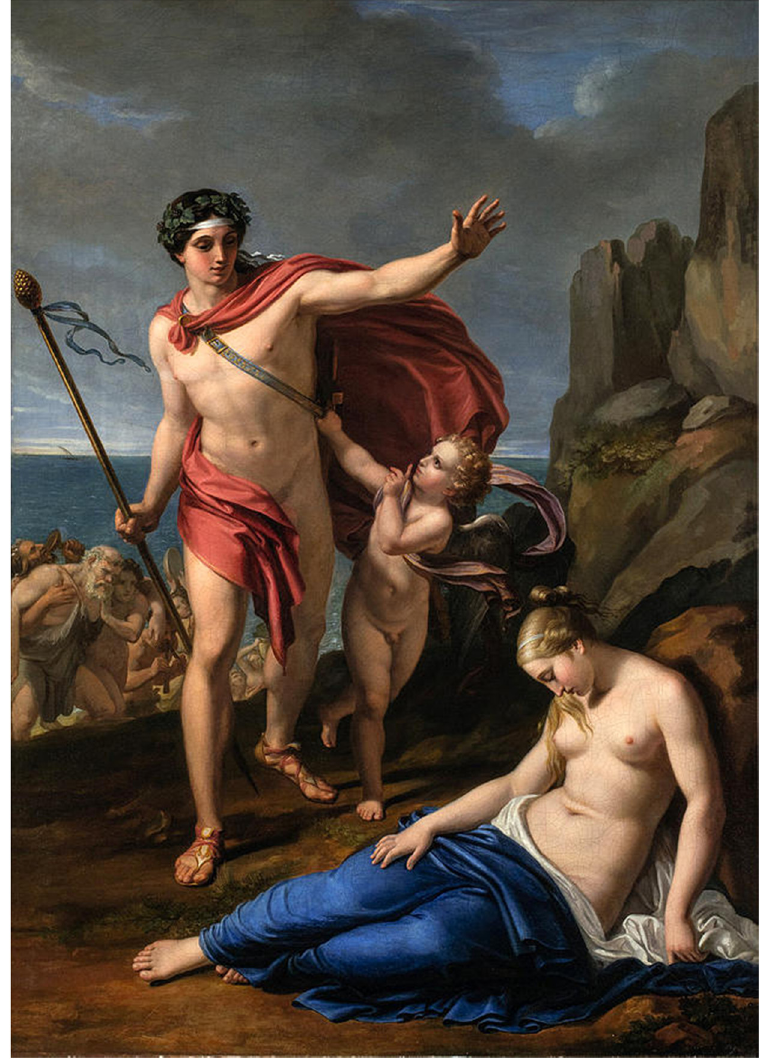
Figure 1: Pietro Benvenuti, Bacchus and Ariadne , 1819. Private Collection, Rome. Fair Use.